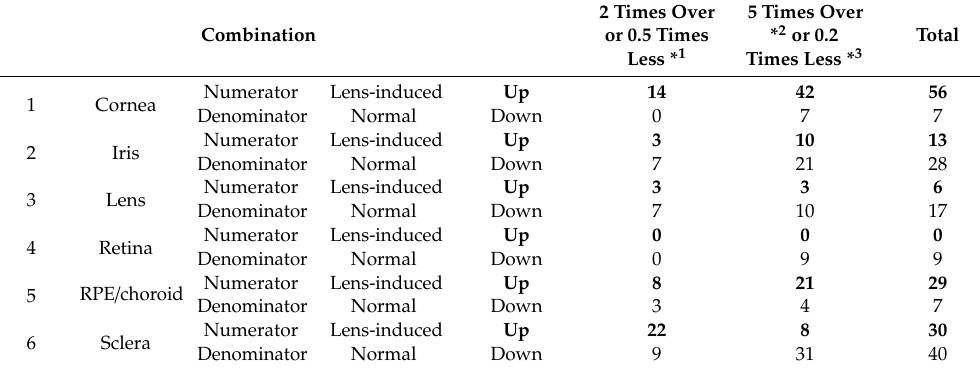
Table 1. The numbers of di ff erentially expressed microRNAs (miRNAs) a ff ected by myopia induction in the individual ocular components.